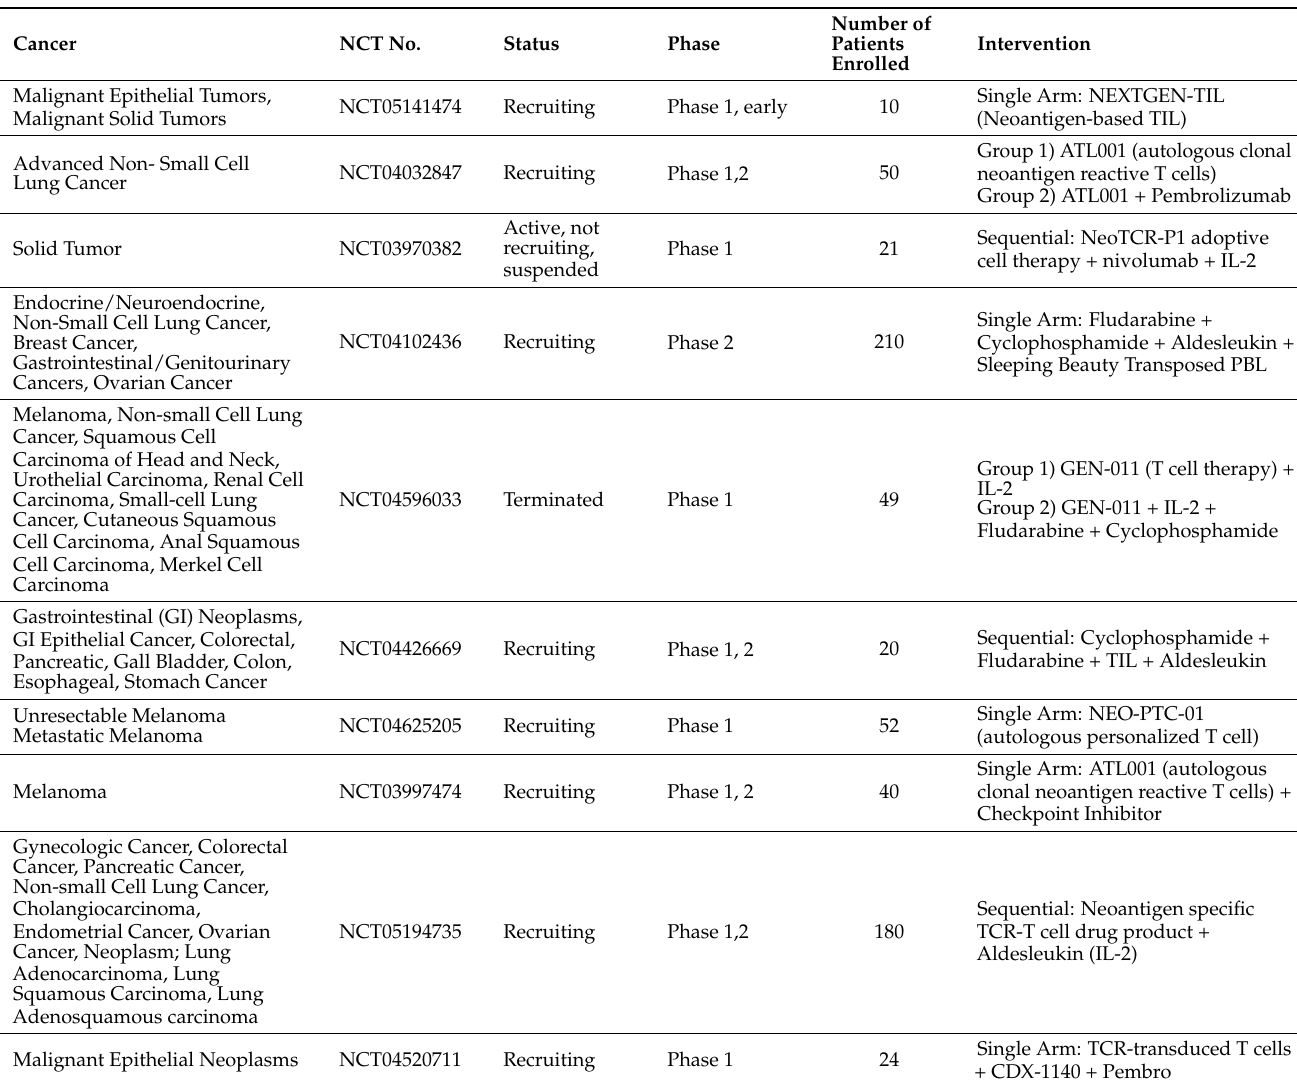
Table 2. Clinical Trials with Neoantigen specific TCR-T cell